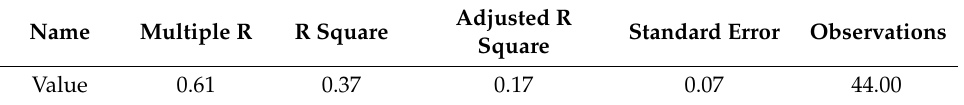
Table 1. Regression statistics.